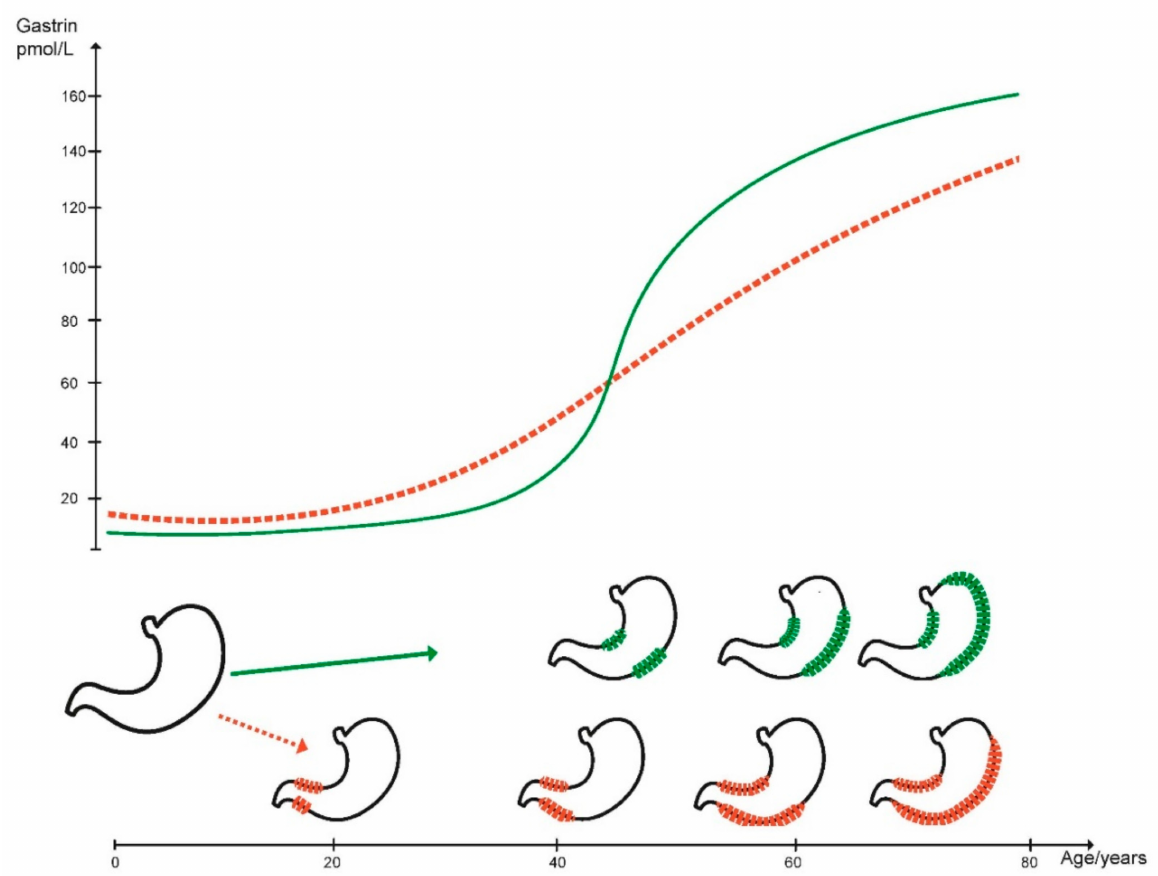
Figure 1. Patients with H. pylori (red line) gradually develop hypergastrinemia after infection in childhood, whereas patients with autoimmune chronic atrophic gastritis develop oxyntic atrophy and secondary hypergastrinemia more rapidly in adulthood (green